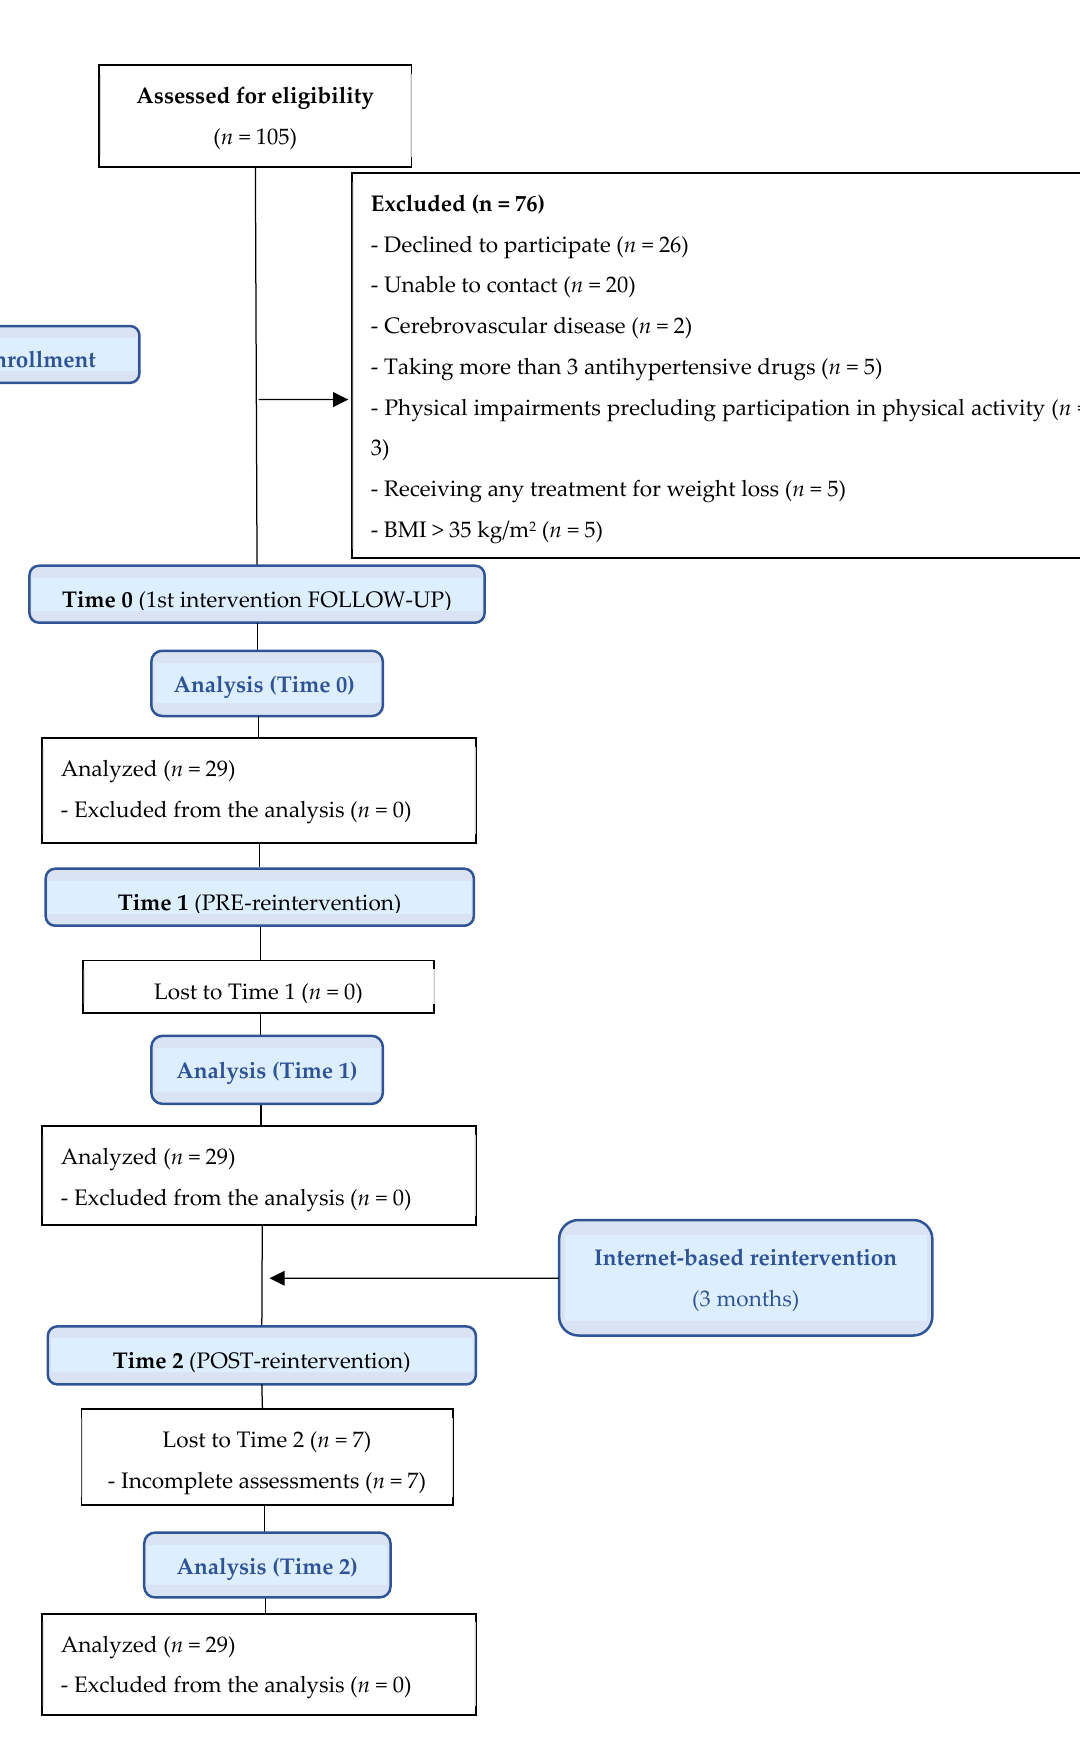
Figure 2. Progression of the participants through the study.